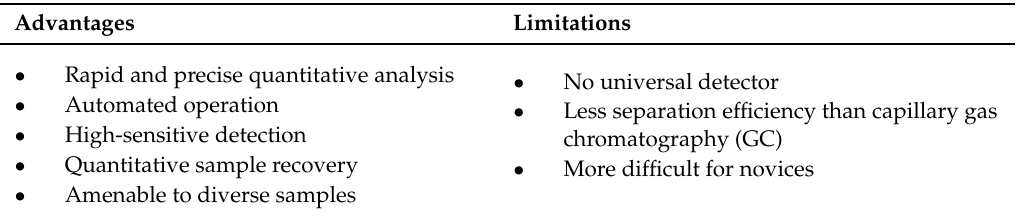
Table 4. Advantages and limitations of high performance liquid chromatography (HPLC)